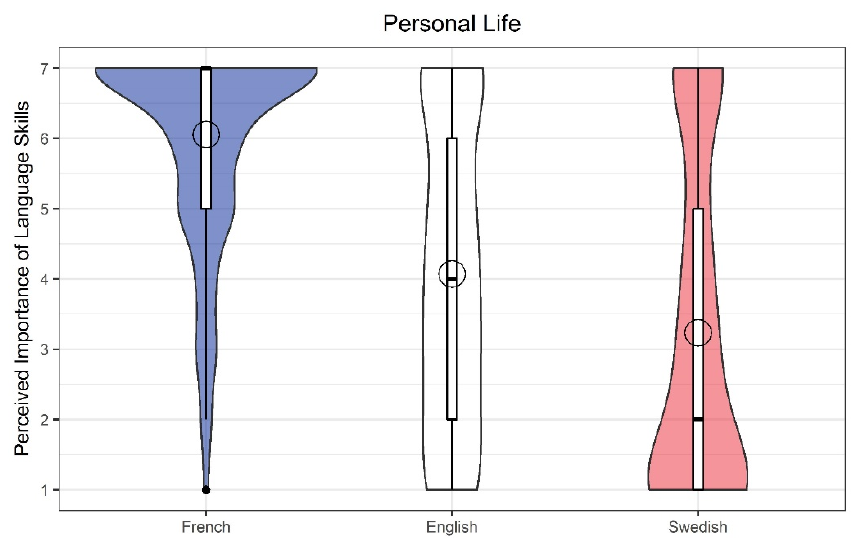
Figure 2. Violin plots overlaid with box plots and means (circles) illustrating the distribution of the perceived importance of each language in personal life. The width of the violin plots represents the proportion of the ratings at each